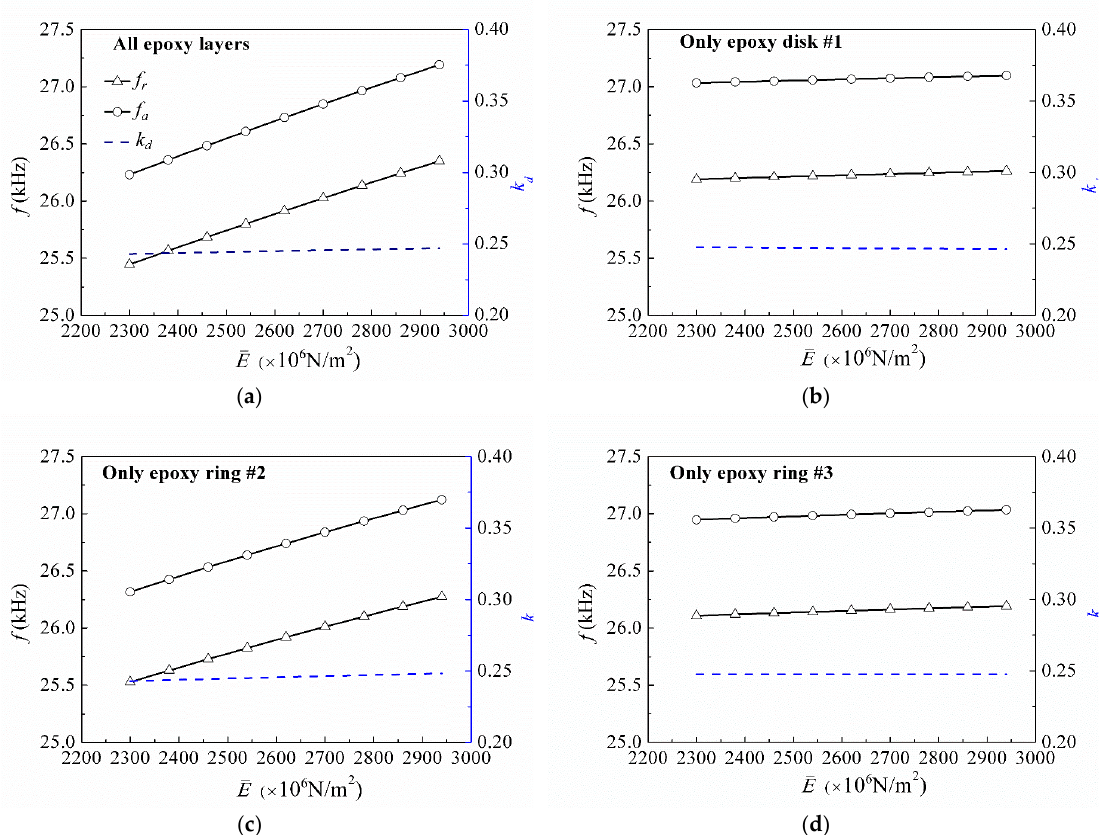
Figure 9. Electromechanical characteristics versus Young’s moduli of the epoxy layers: ( a ) all epoxy layers; ( b ) only epoxy disk #1; ( c ) only epoxy ring #2; ( d ) only epoxy ring #3.